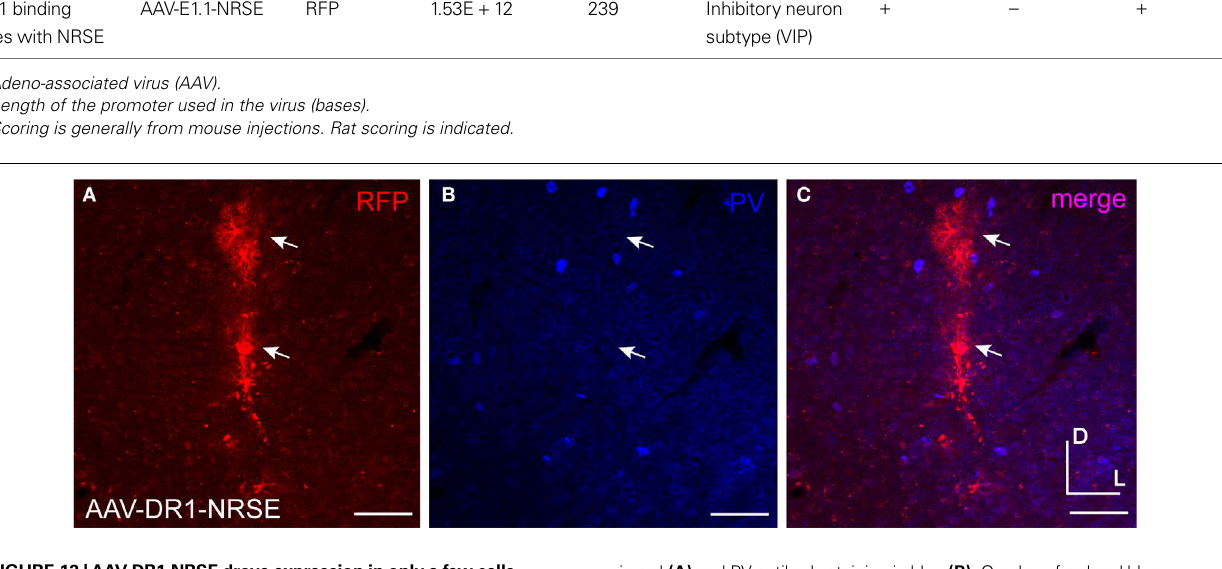
in red (A) and PV antibody staining in blue (B) . Overlap of red and blue images is shown in (C) . Glia are marked with arrows. Dorsal (D) and lateral (L) directions for all images are as indicated in (C) . Scale bars are 50